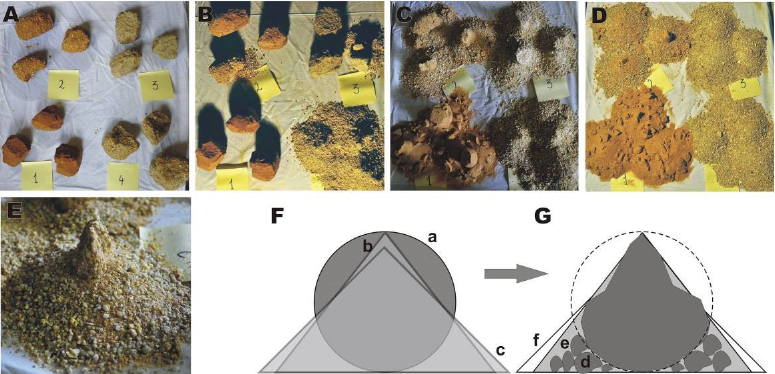
Figure 6. Formation of molards. ( A – D ) Evolution of ~8 cm large frozen ground blocks of different composition (1—fine sand; 2—fine, medium and coarse sand; 3–4—granule-rich medium–coarse sand), taken at about 6 h intervals. ( E ) Detail of a molard after 24 h. ( F – G ) Schematic evolution of an isometric ice-cemented conglomeratic boulder whilst defrosting; the initial sphere (a) would degrade into a cone of 51.9° (b), but will adopt the maximum repose angle of 45° (c). On the right, the intermediate molard is shown. Initially chaotic fragments are released (d), that end by forming a high-sloping talus (e), that will evolve into a less-sloping talus (f). The original boulder (dark grey) might be exposed for a short time until it degrades to form the cone apex. Modified from Milana [20].